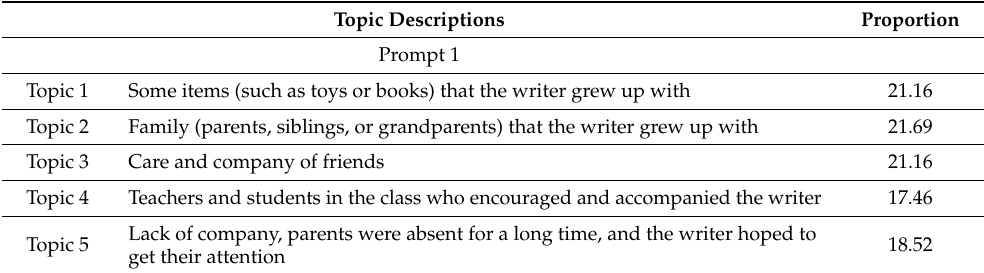
Figure 2. Topic proportions over scores. The horizontal axis represents the topics in a given prompt; the corresponding labels of topics are included in Table 2. Table 2. Substantive labels are assigned to the final topic